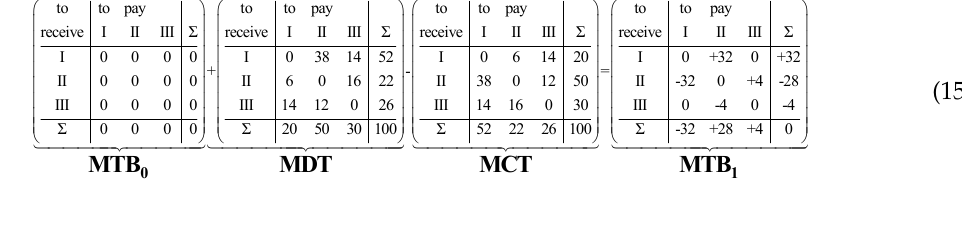
Table 6. The Matrix of a Trial Balance MTB in matrix